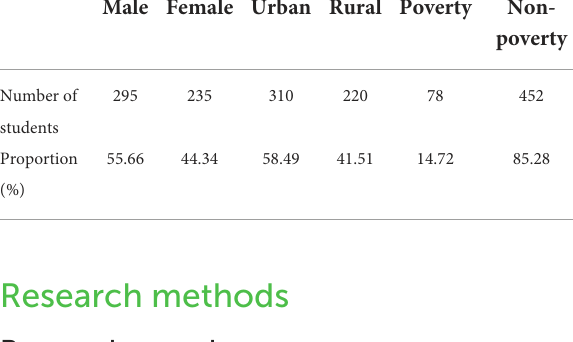
TABLE 1 Sample distribution. Male Female Urban Rural